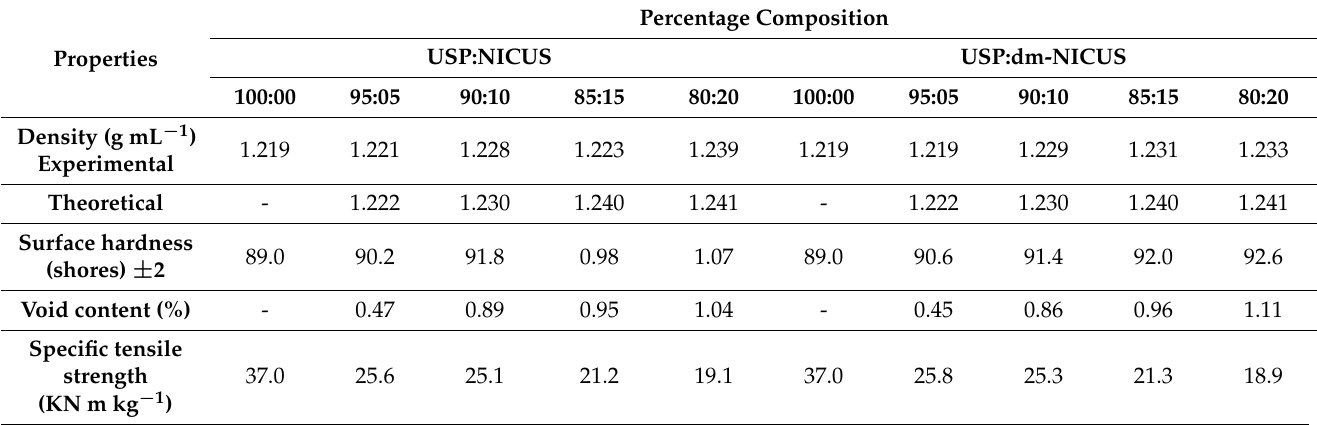
Table 9. Effect of ageing on tensile strength of unsaturated polyester thermoset composites.